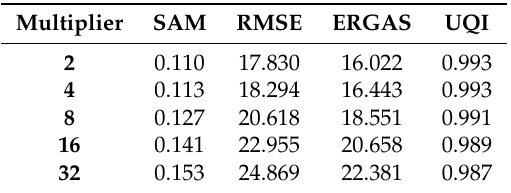
Figure 14. Image differences between the generated images and the original NIR (band 5) and SWIR (bands 6 and 7) for the Landsat set brought to 30 m pixel size following the Wald’s protocol. Table 7. Landsat spectral quality indexes between the generated and original spectral compositions resized to 30 m pixel resolution.